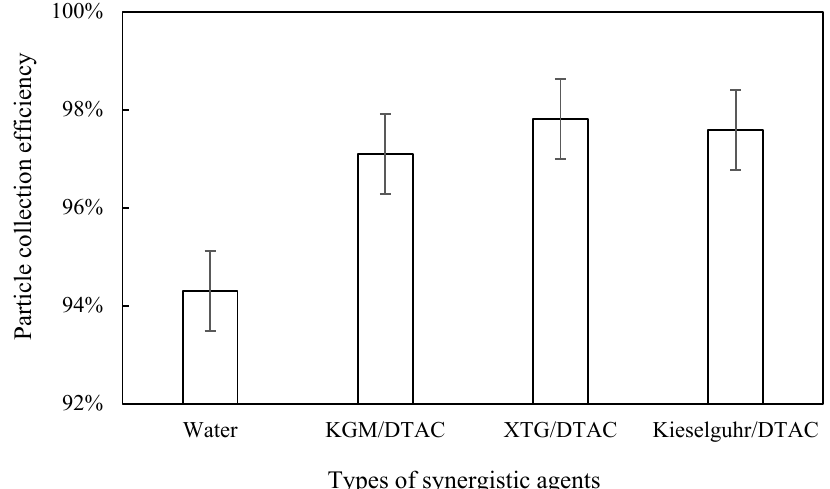
Figure 14. Effect of synergistic types on dust removal efficiency.